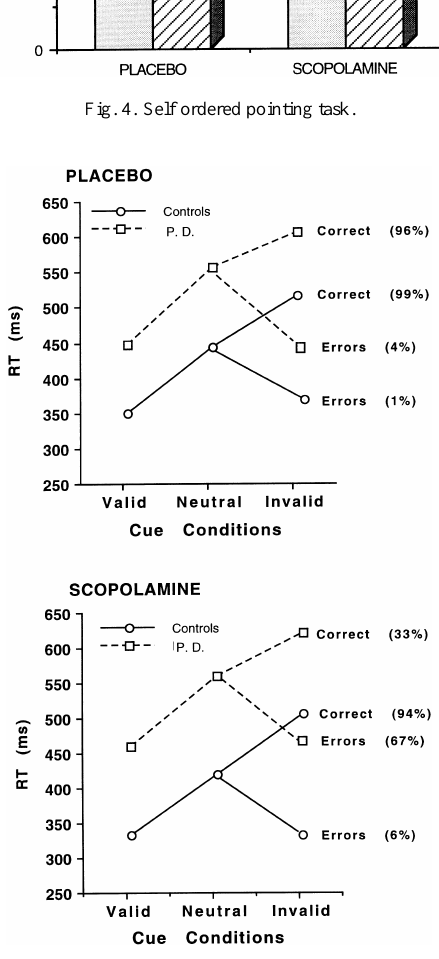
Fig. 5. Shifting reaction time